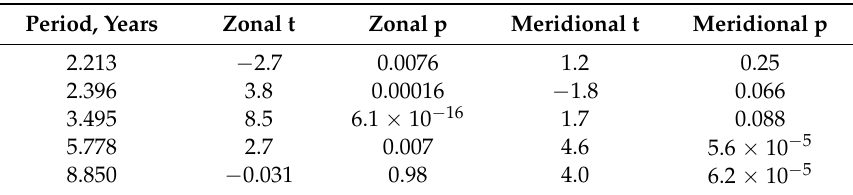
Table 11. Regime differences for subdecadal tidal components in multiple linear regression statistics with the ONI, for a lag time of 0.22 years.